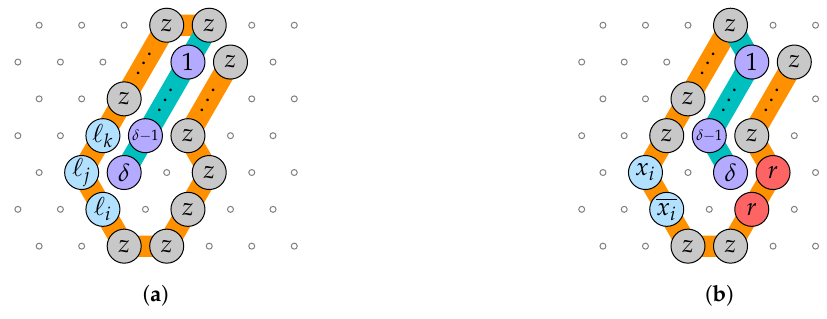
Figure 20. The reduction for 3-SAT to the rule design problem for delay δ ě 2. ( a ) The